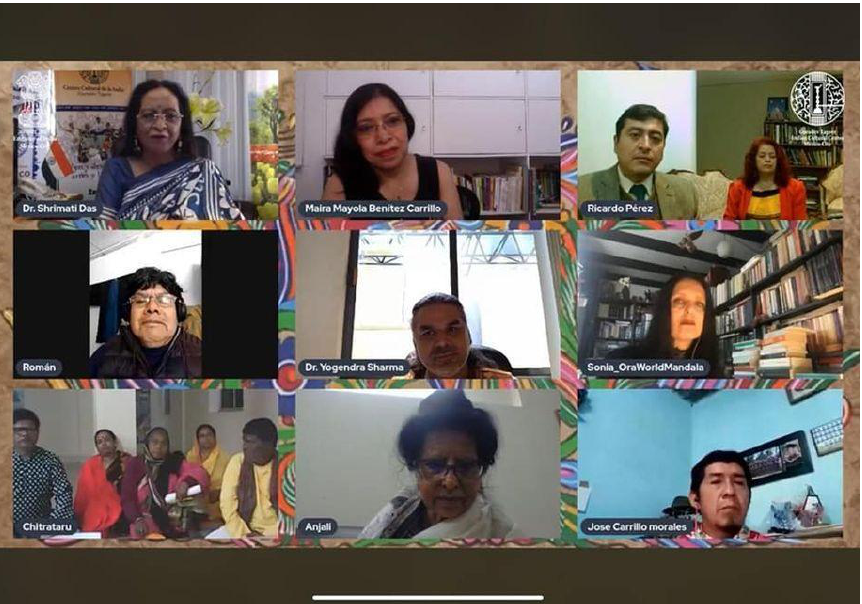
Figure 5. Third Left Panel from Top: Manu Chitrakar, Swarna Chitrakar, Rani Chitrakar, Manimala Chitrakar, and Gurupada Chitrakar Live in Online Exhibition “Life on Scroll”, Co-hosted by Gurudev Tagore Centre For Culture, Embassy of India Mexico, and IIT Kharagpur, 20 February 2021. Photo Courtesy Gurudev Tagor Centre for Culture.